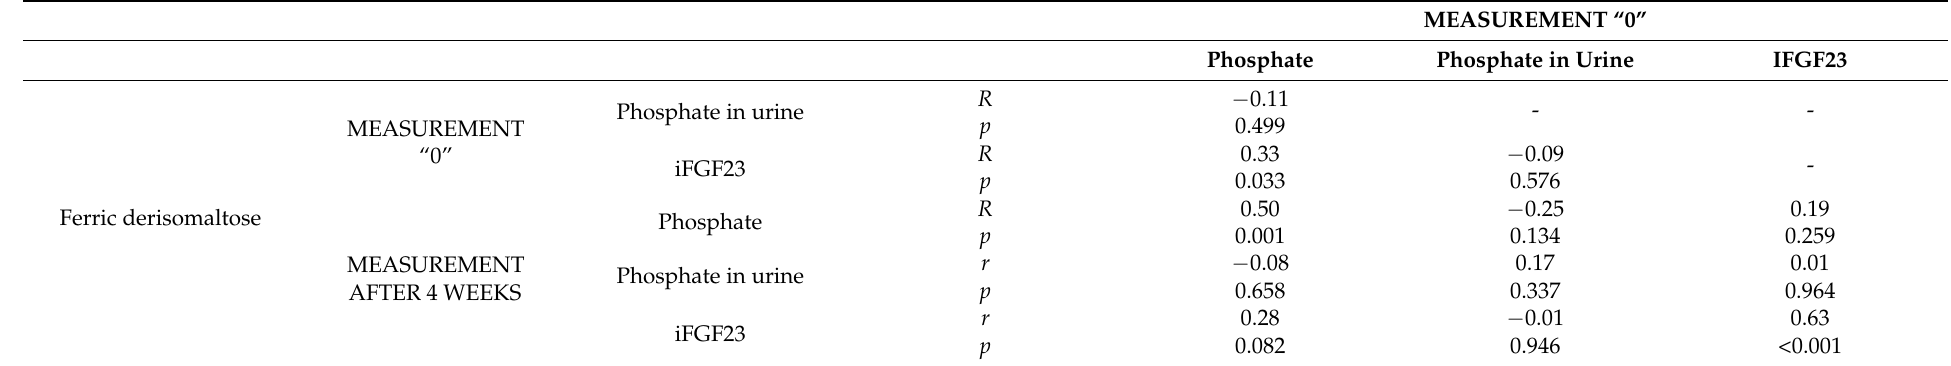
Table 6. The relationship of phosphorus and iFGF23 levels in individual measurements, broken down by drug